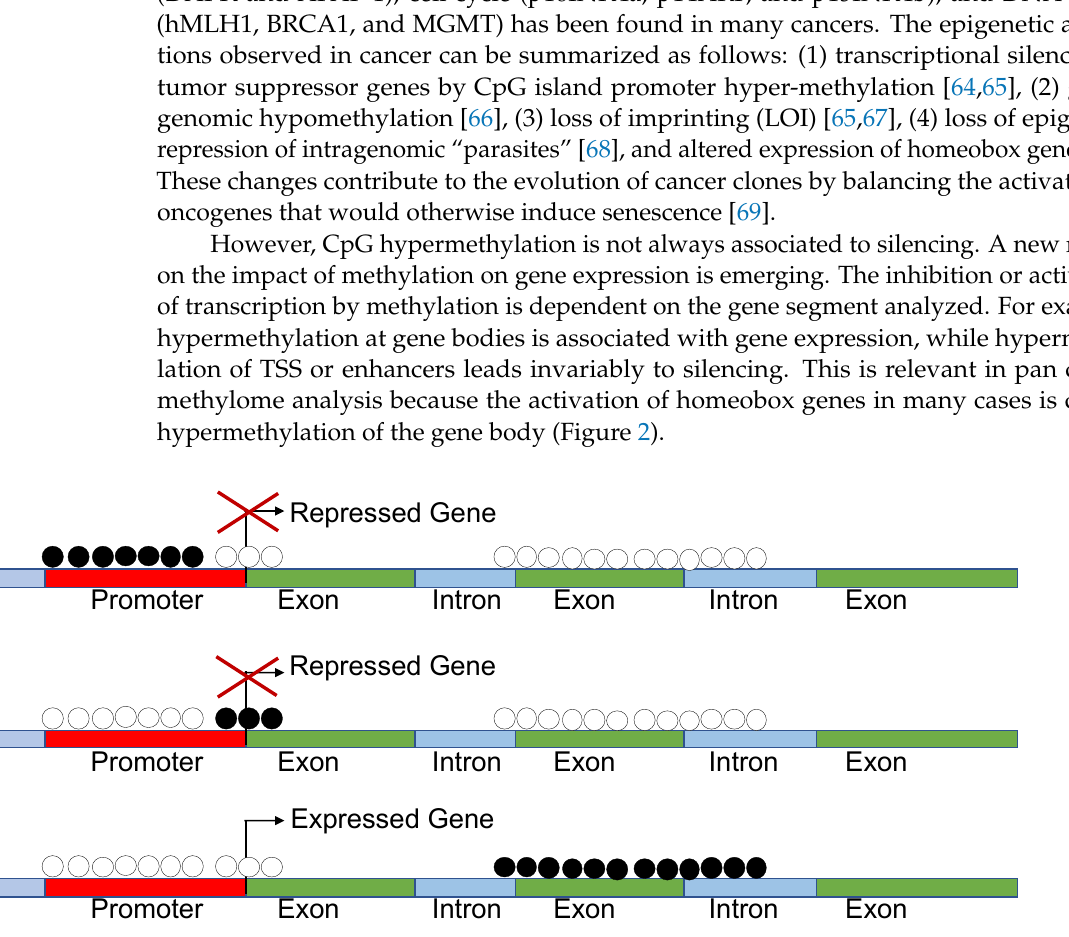
Figure 2. Methylation is not always associated with silencing of gene expression. ( A – C ) These show that methylation of the promoters and transcription start sites (TSS) leads to repression of gene expression, while methylation of the gene body results in increased expression as found in pan cancer methylomes.